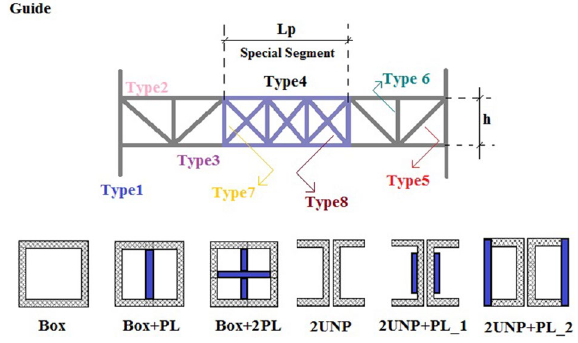
Fig. 6 cross sections